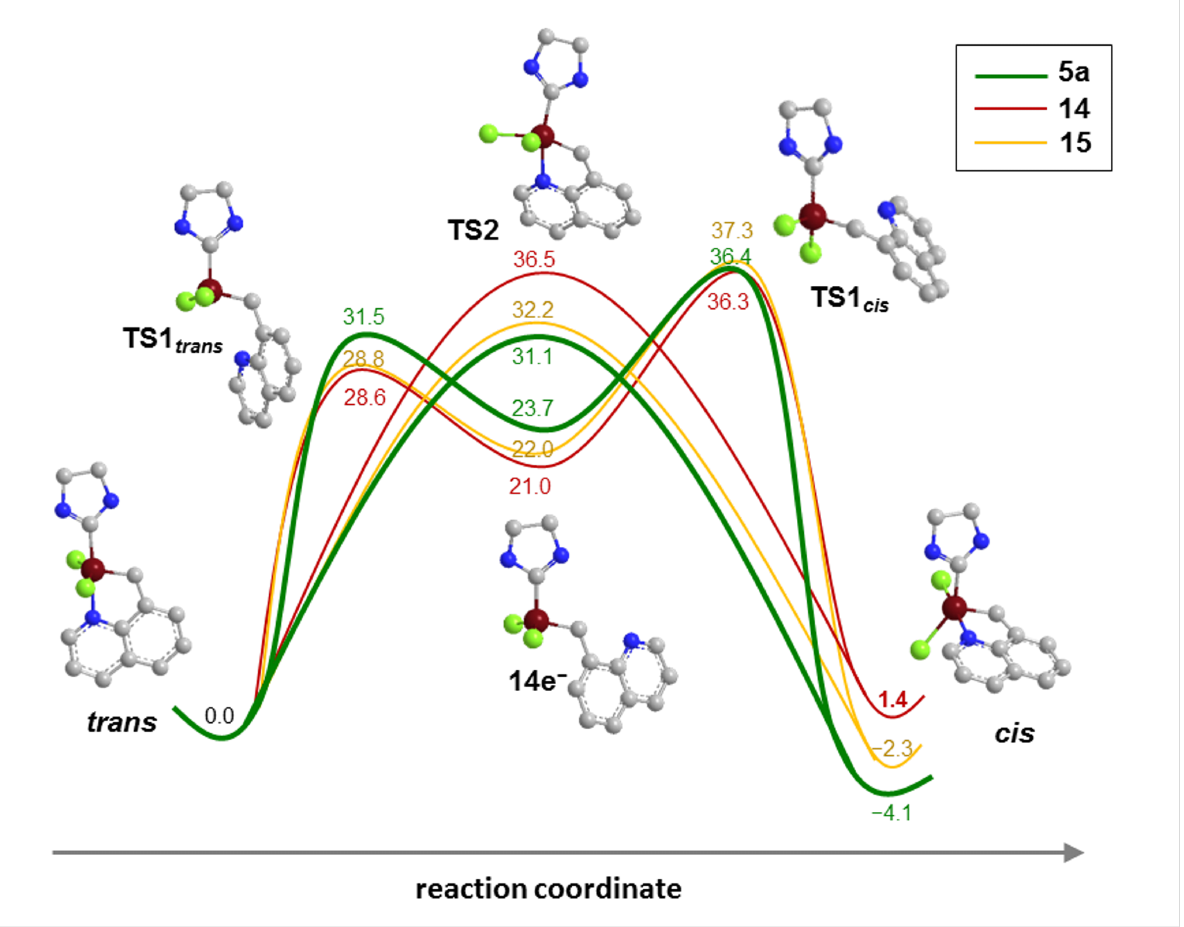
Figure 4: Energy profile of trans–cis isomerization, modelled in CH 2 Cl 2 , ( Δ E in kcal/mol). Geometry optimizations BP86//SVP, solvent effects included by single point calculations, using M06//TZVP.